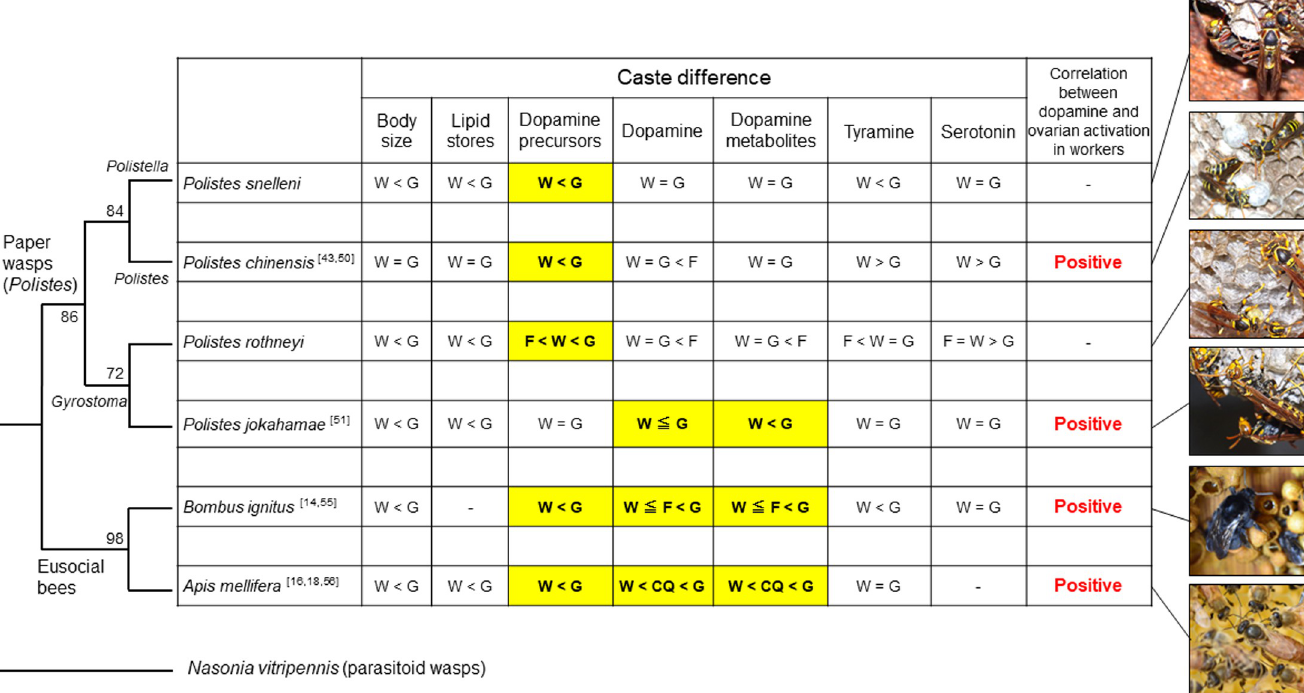
PLOS ONE | https://doi.org/10.1371/journal.pone.0280881 January 26,